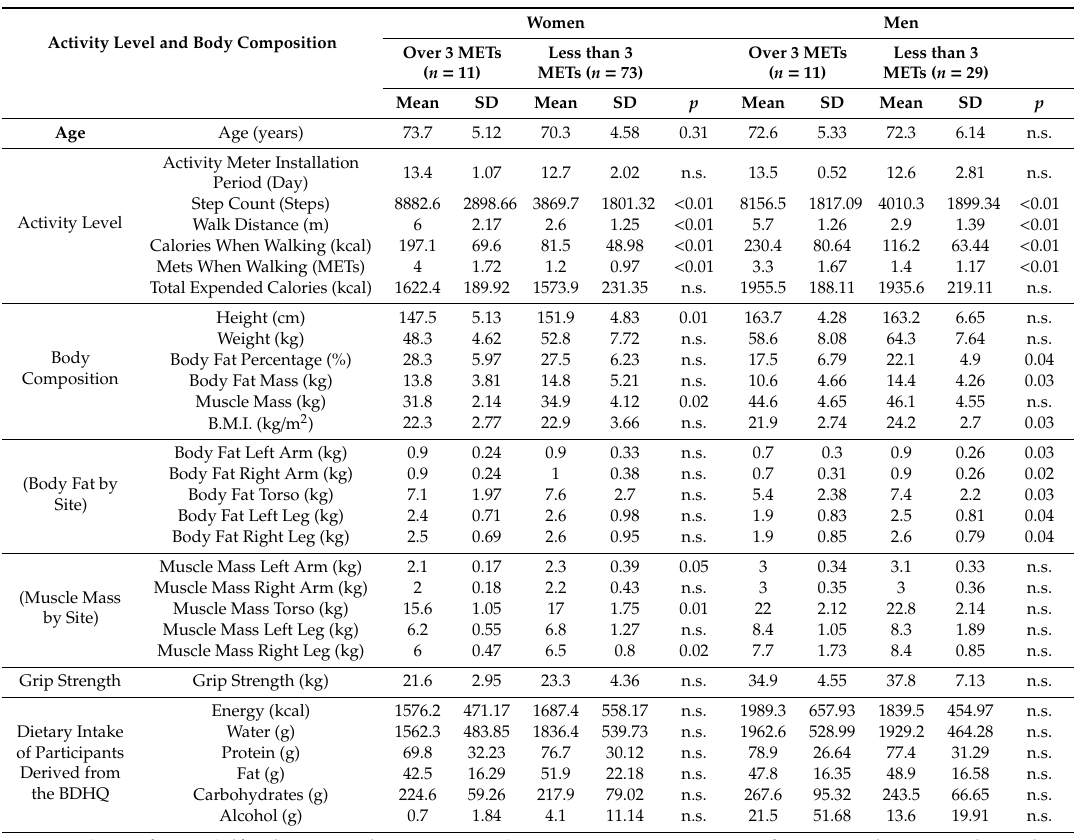
Table 3. Comparison by activity